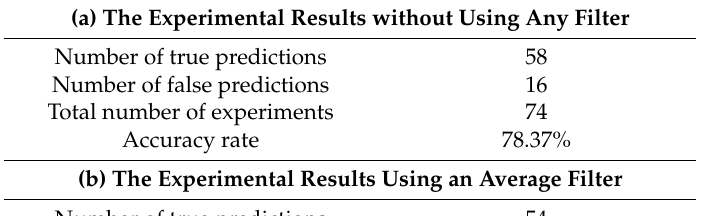
Table 4. A total of 148 experiments for indoor positioning detection using trilateration algorithm.